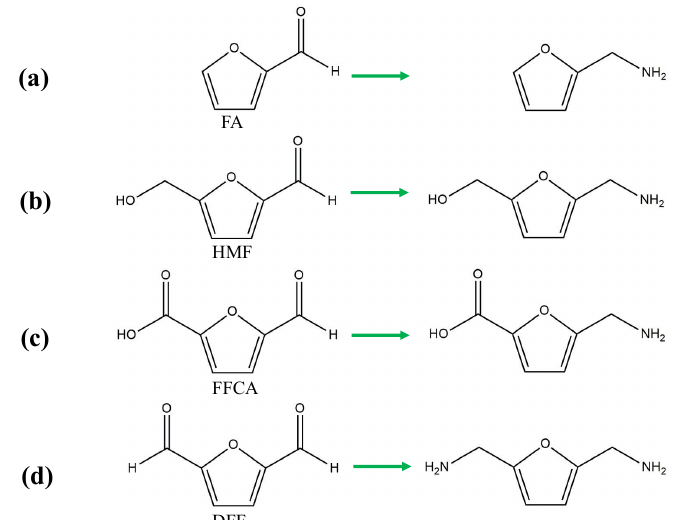
Figure 4. Schematic representation of furan-derivatives that have been reported in the literature to be transformed by aminotransferases to their corresponding amines [112,113,117]. ( a ) HMF to HMFA, ( b ) FA to FFA, ( c ) FFCA and ( d ) DFF to monoamine and diamine respectively. HMF : 5-hydroxymethylfurfural, DFF : furan-2,5-dicarbaldehyde, FFCA : 2,5-formylfurancarboxylic acid, FA : furfural, 2-furaldehyde.